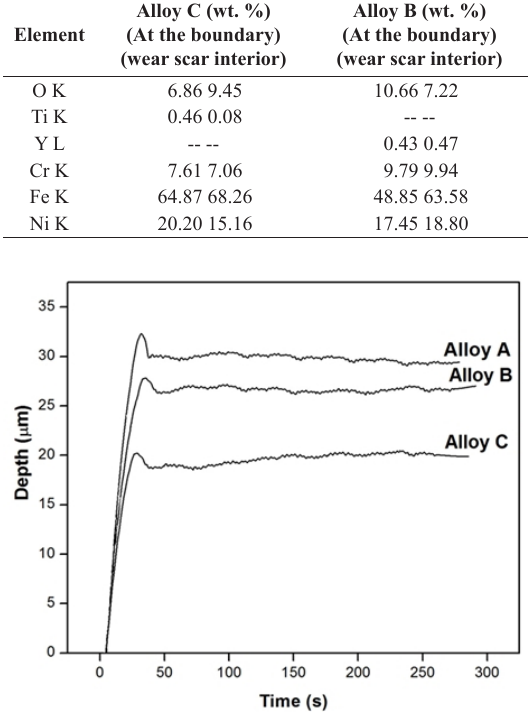
Fig. 8 Variation of wear depth vs. time of the sintered